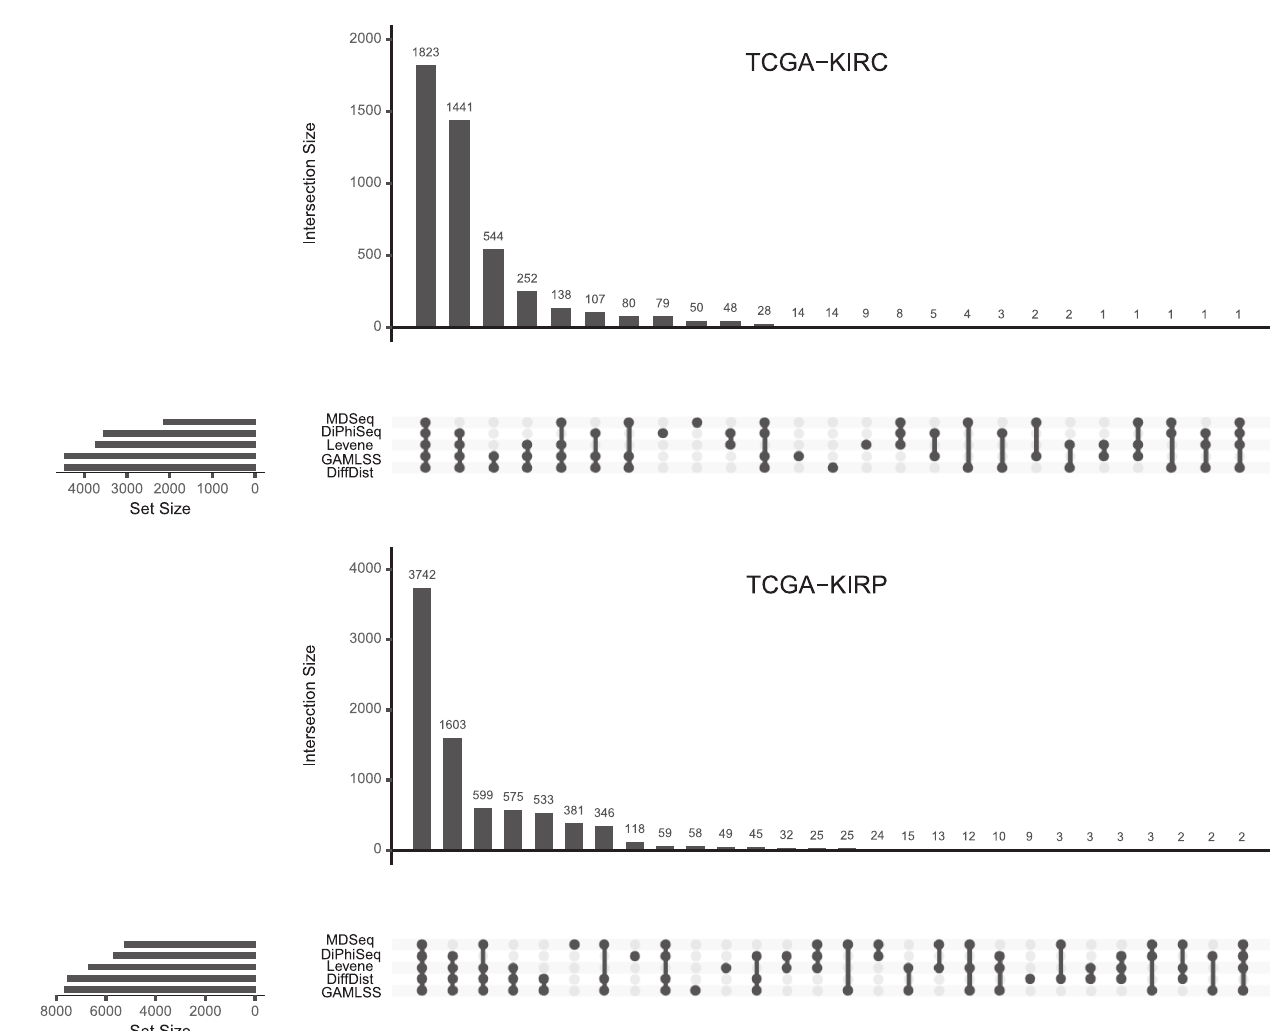
Fig 5. Overdispersed genes in tumors identified by the evaluated methods among non-differentially expressed genes. Intersections of sets of overdispersed genes in tumors identified by Levene’s test, MDSeq, DiPhiSeq, GAMLSS and DiffDist among non-differentially expressed genes for (A) the kidney renal clear cell carcinoma dataset (TCGA-KIRC) and (B) the kidney renal papillary cell carcinoma dataset (TCGA-KIRP). Non-differentially expressed genes were identified by MDSeq.